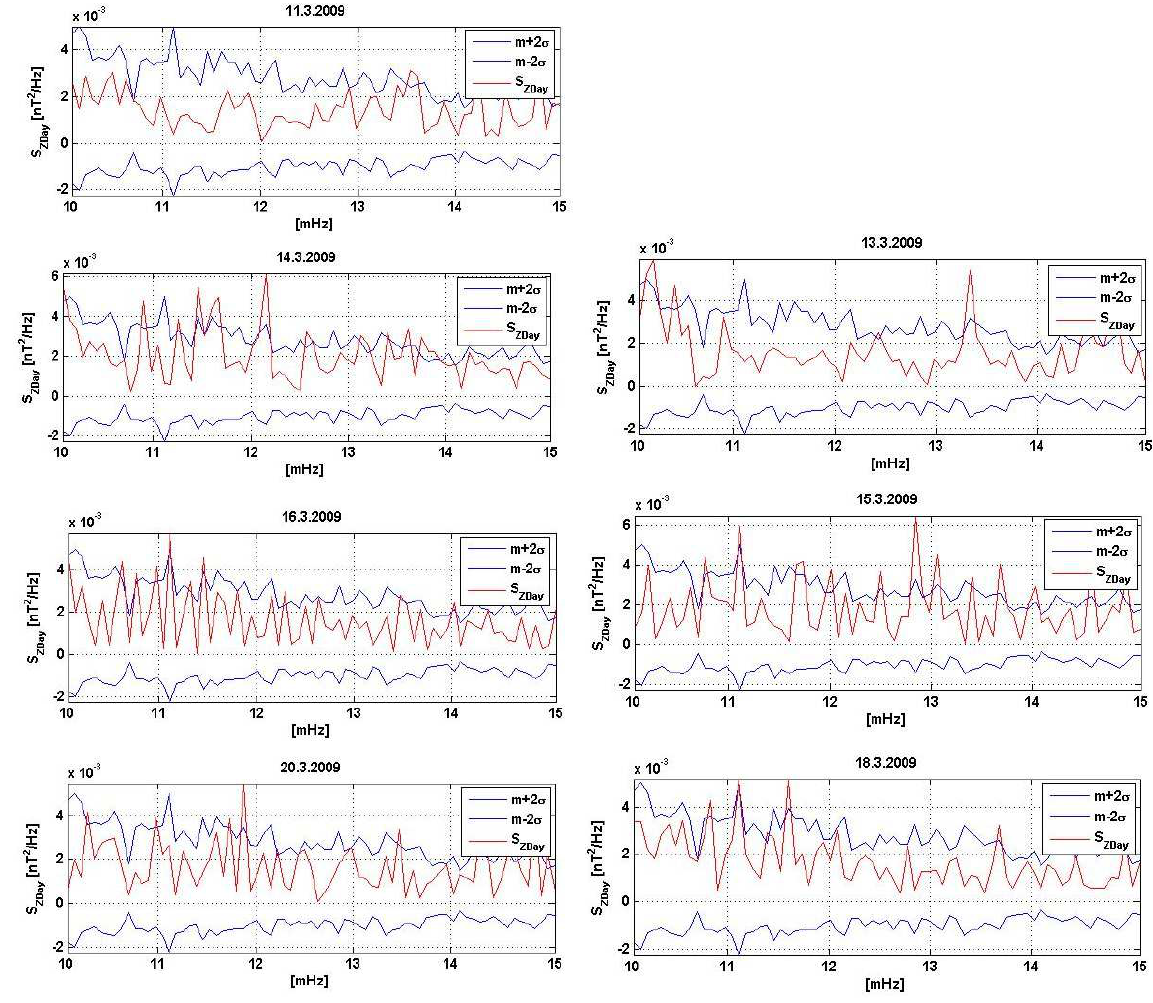
Fig. 7. Daily vertical PSD in the frequency range 10–15mHz exceeding µ ± 2 σ from 11 March 2009 to 20 March 2009 (shaded area in Fig.